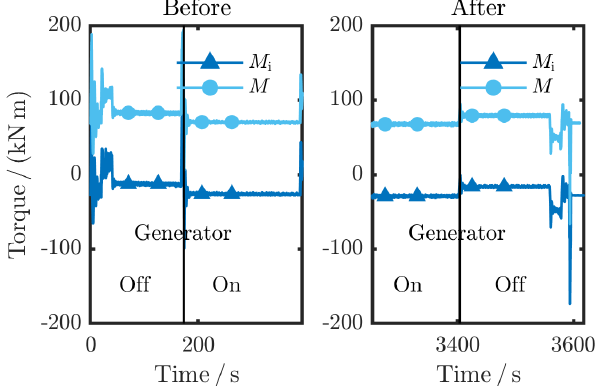
Figure 5. Tared measurement data of a load cycle with stepwise increasing (inc) and decreasing (dec) torque from 0MNm up to